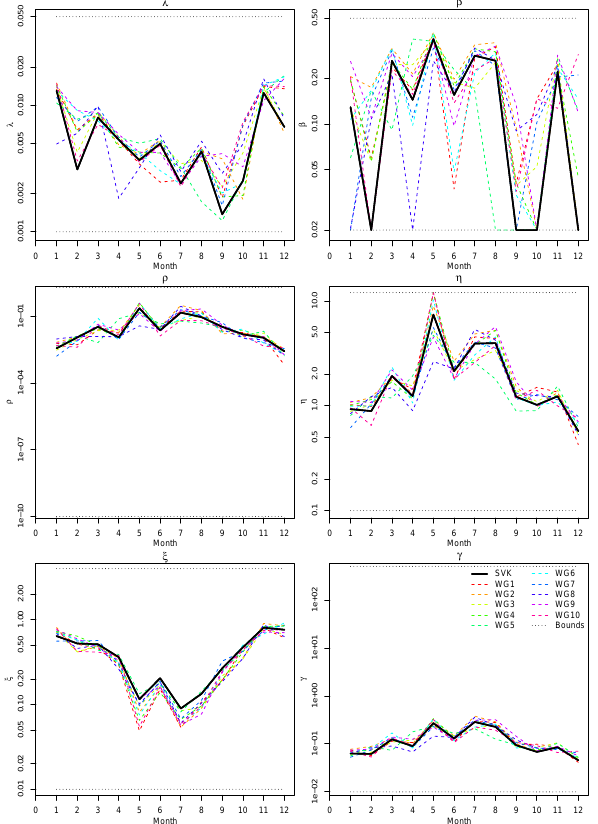
Figure 4. Monthly variation of the model parameters estimated from the SVK data set and from the simulated 10 WG data sets. Upper and lower fitting bounds are shown in light